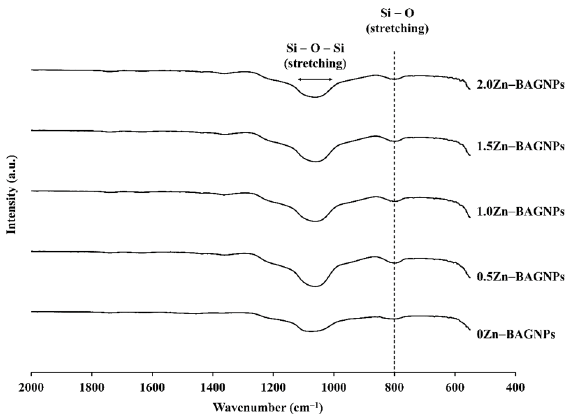
Figure 4. FTIR spectra of Zn-BAGNPs after calcination and extra washing.